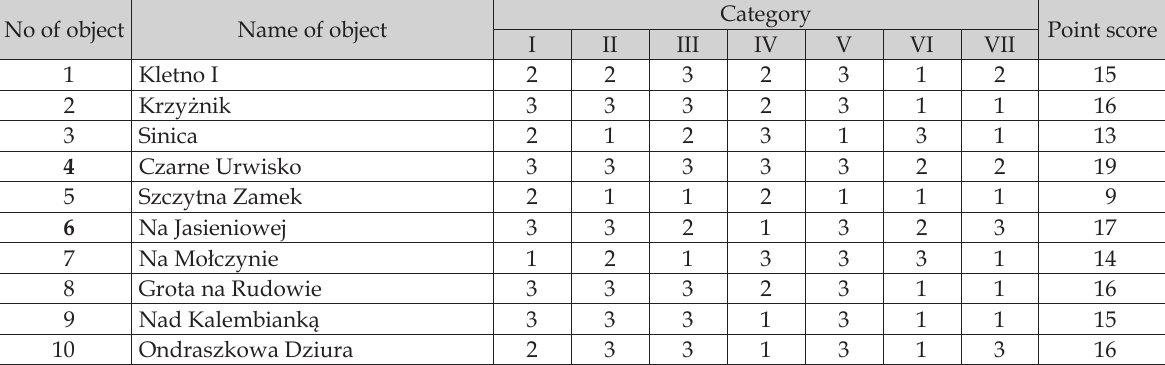
Table 3. Results of geotourism valorisation of selected